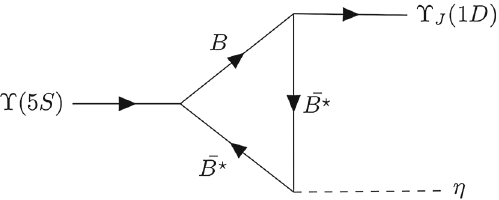
Fig. 1 Example of triangular B meson loops diagram expected to con- tribute to the Υ ( 5 S ) → ηΥ J ( 1 D ) transition, from [37]